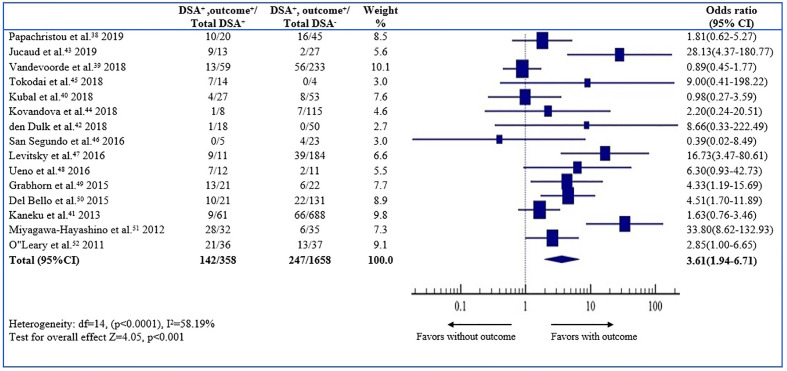
Association between de novo DSAs and the risk of overall outcome. Forest plot of comparison of patients with de novo DSA vs. those without de novo DSA with outcome.